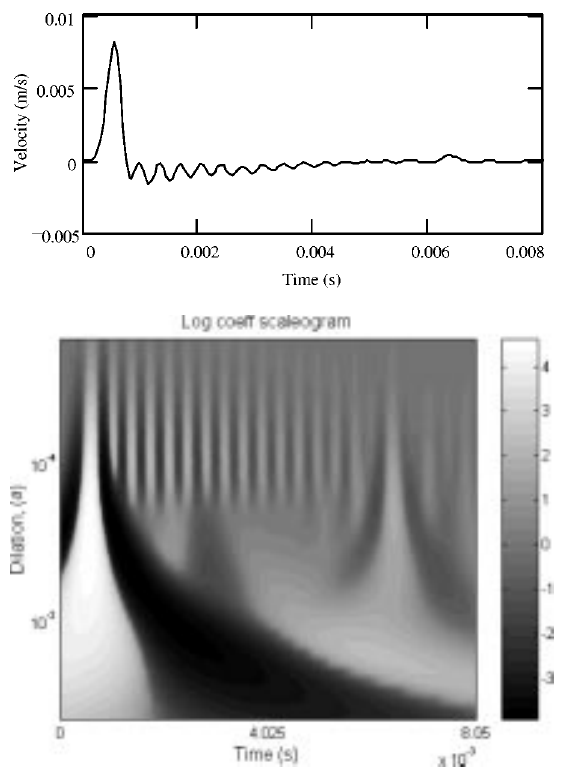
Fig. 2. The Fourier filtered velocity trace (top) and wavelet transform scaleogram (bottom) of an eleven metre pile in stiff/very stiff